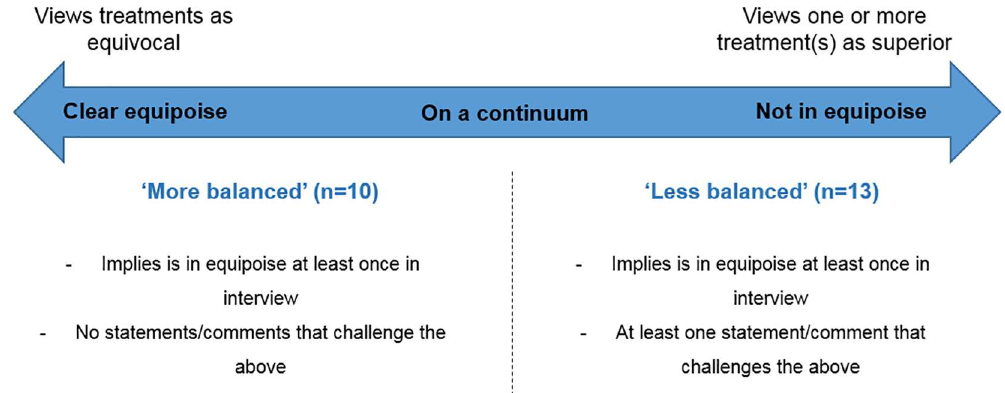
Fig 1. Clinicians’ individual perceptions of equipoise, based on interview accounts.